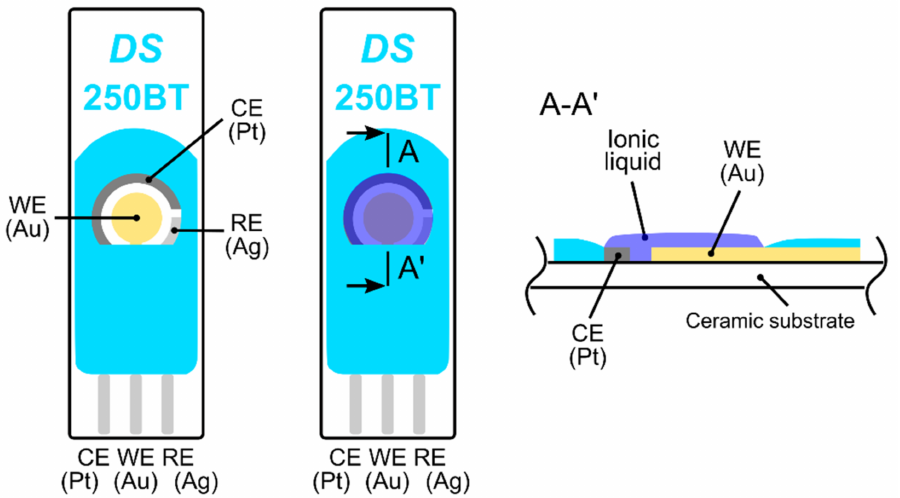
Figure 1. Fully-planar screen printed electrodes (250BT, DropSens); from the left: top view of the electrode topology, top view and cross section of the electrode topology with the ionic liquid